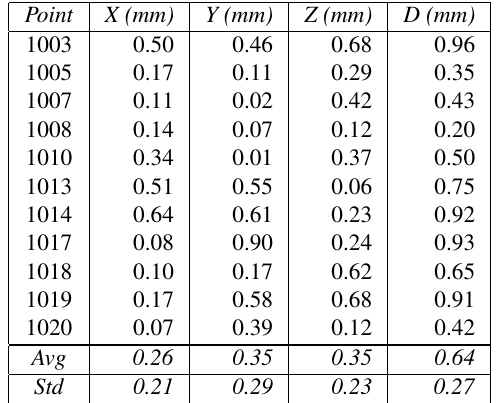
Figure 17. Accuracy check on CPs result- Case 2